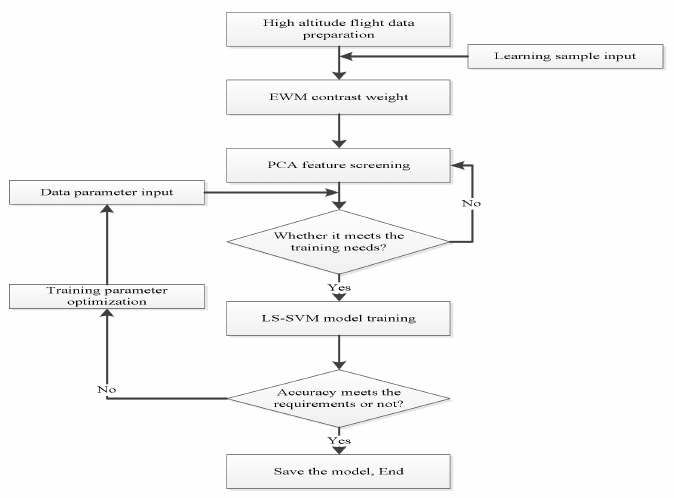
Figure 2. Flow chart of flight data fitting based on improved LS-SVM.